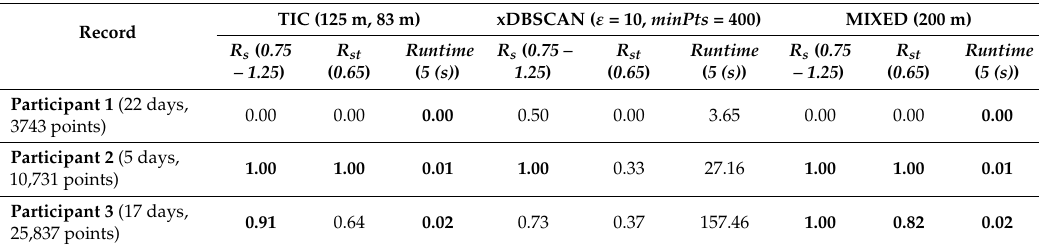
Table 4. Application field data (AFD) evaluation results for TIC, xDBSCAN, and MIXED (bold values indicate that thresholds are